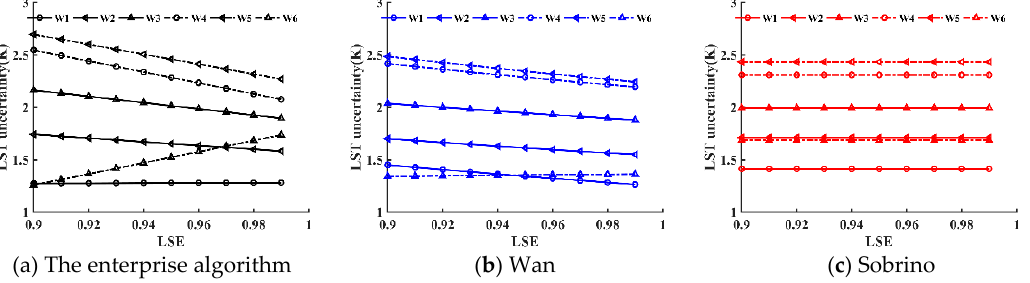
Figure 3. Land surface temperature (LST) uncertainty attributed to the sensor noise at six water vapor content subranges. The mean emissivity was set from 0.9 to 0.99 with a step of 0.01. W1–W6 are the atmospheric water vapor range (W1 = 0.0–2.5 cm; W2 = 2.0–3.5 cm; W3 = 3.0–4.5 cm; W4 = 4.0–5.5 cm; W5 = 5.0–7.0 cm, and W6 = 0.0–7.0 cm).